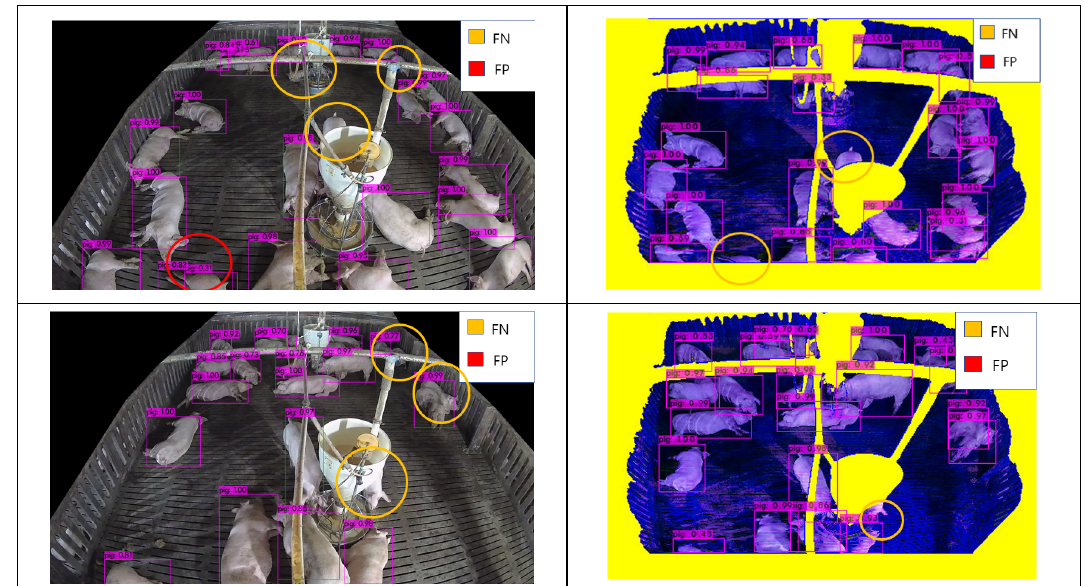
Figure 14. Detection results for Hadong with object detectors [41] (Baseline vs. Proposed) that shows solved cases and unsolved cases.